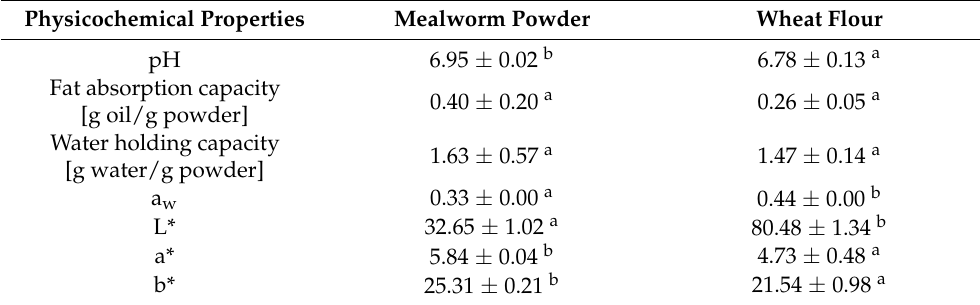
Table 1. Wheat flour and mealworm powder characterization used for bread making.